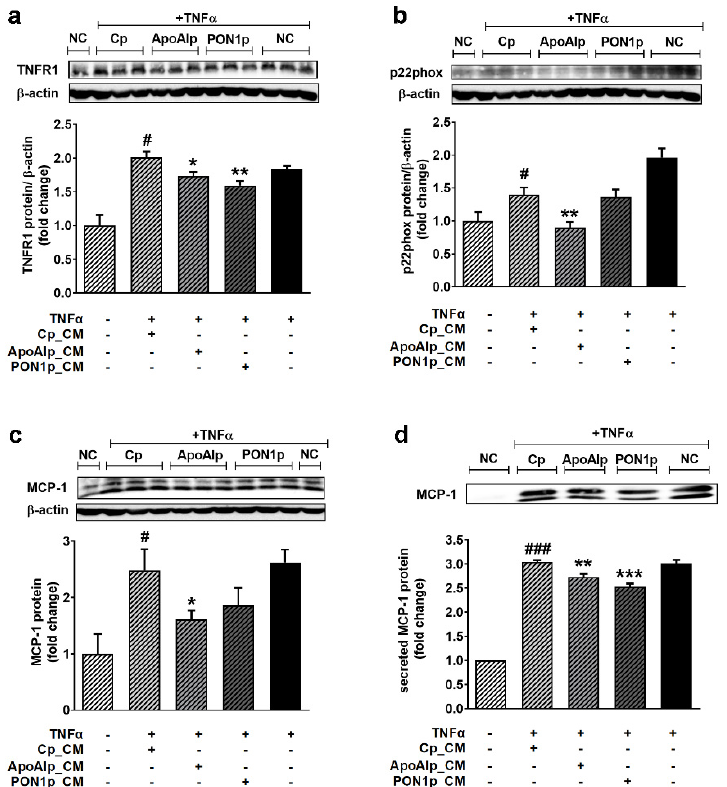
Figure 5. Conditioned media from Caco-2 overexpressing ApoAI and PON1 decrease inflammation in TNF- α activated EC. ( a ) TNFR1, ( b ) p22phox, and ( c ) MCP-1 protein expression relative to β -actin (representative blot and densitometric analysis). ( d ) Secreted MCP-1 in the culture medium relative to total cell protein (representative blots and densitometric analysis). Cp, control CRISPR activation plasmid; ApoAIp, CRISPR activation plasmids for ApoAI; PON1p, CRISPR activation plasmids for PON1; CM, conditioned media; NC, negative control–EC incubated with CM from untransfected Caco-2 cells. All data are expressed as fold change versus Cp and presented as mean ± SEM of 3 independent experiments. # p < 0.05, ### p < 0.001 vs. NC; * p < 0.05, ** p < 0.01, *** p < 0.001 vs. Cp_CM.